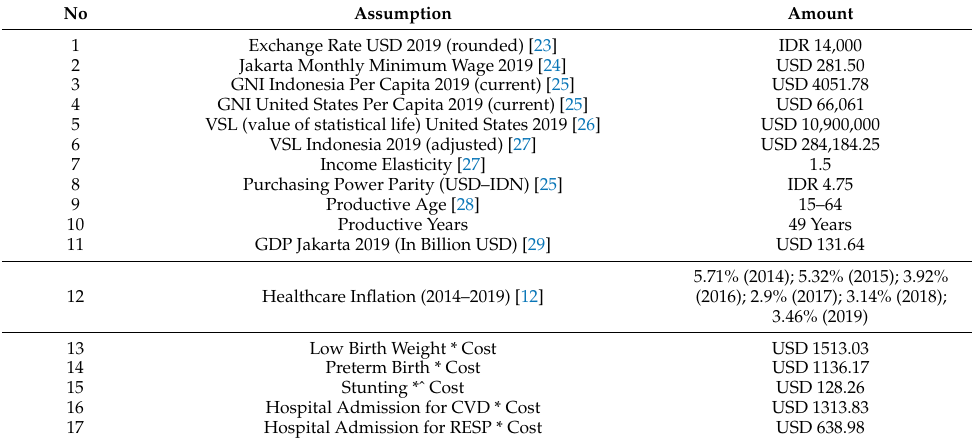
Table 3. Assumptions used for economic impact estimates.